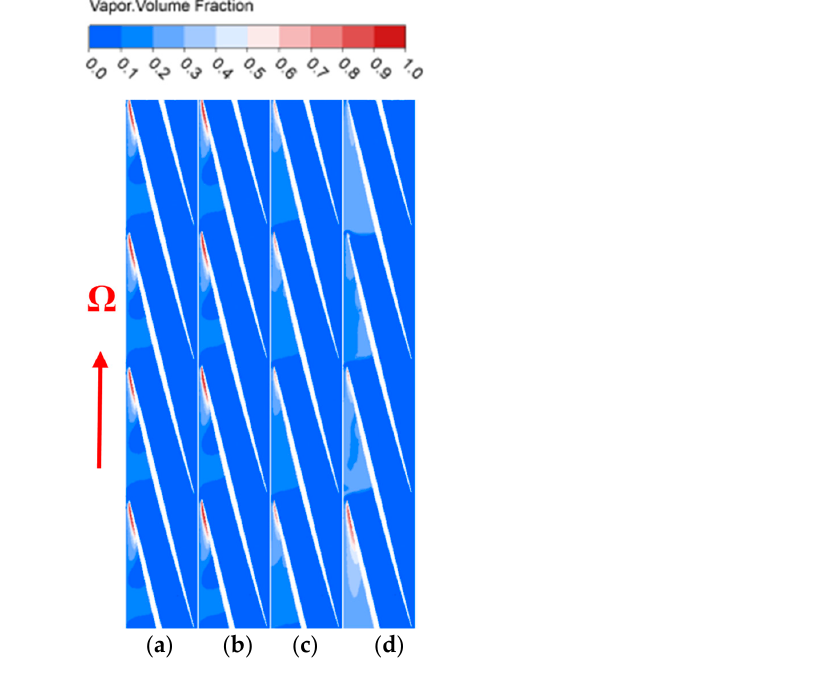
Figure 10. VVF and pressure distribution on suction surface (SS) and pressure surface (PS) along the blade streamline at 0.5 times blade height ( Δ = 3%).